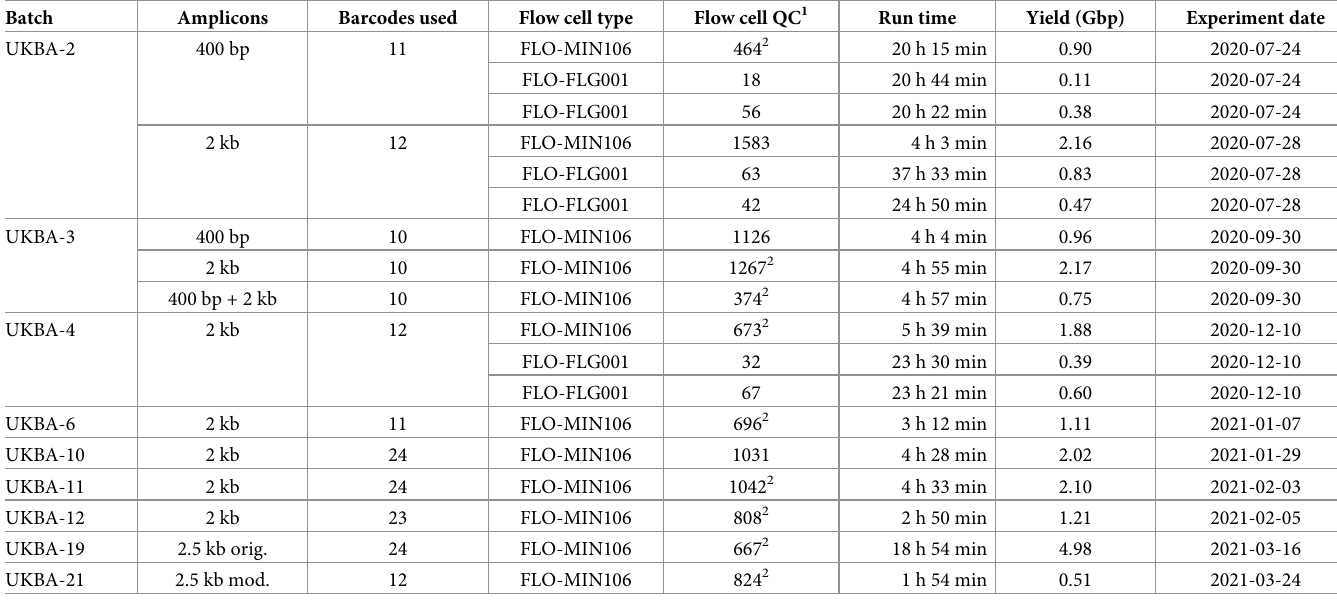
Table 1. Overview of the MinION sequencing runs.